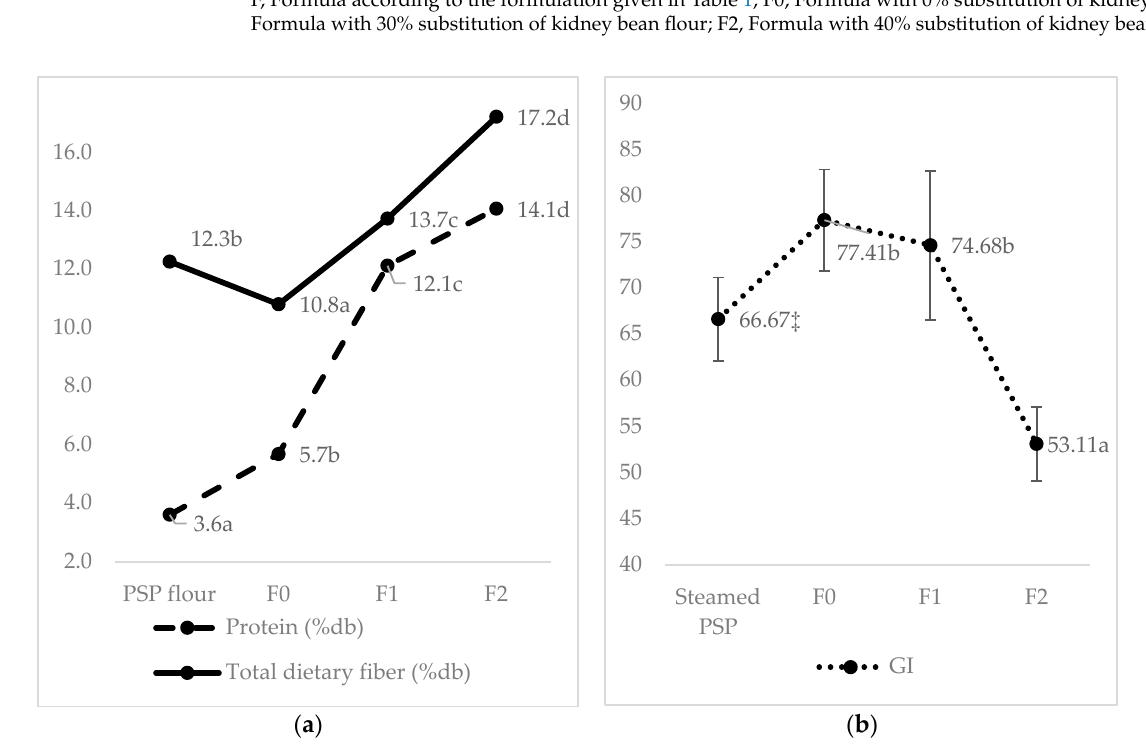
Figure 3. Content of protein and total dietary fiber (%db) (means ± SD) ( a ) and GI (means ± SEM) ( b ) are affected by processing type, i.e., drying for PSP flour, wet heating for steamed PSP, and extruded PSP with different levels of kidney bean substitution (0% for F0, 30% for F1, and 40% for F2). a–d , Different superscript letters in each column are significantly different at p < 0.05, analyzed using one-way ANOVA and the Duncan post hoc test; ‡ Data was adopted from previous unpublished Sweet